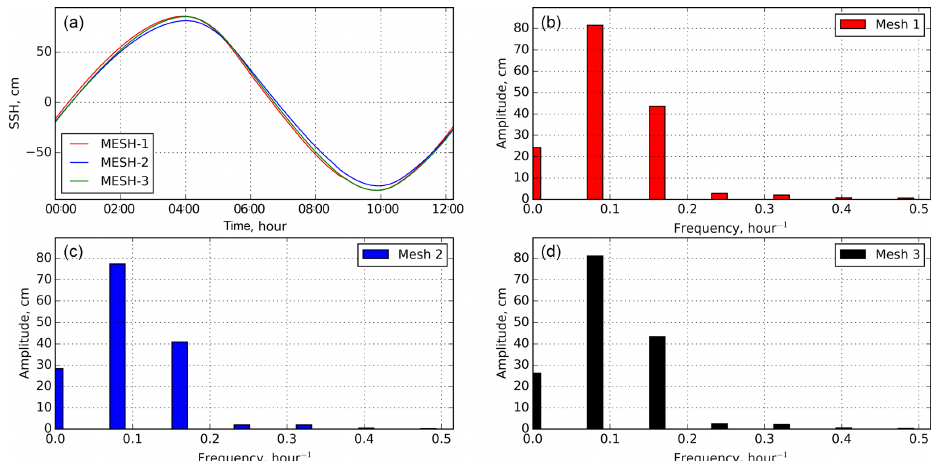
Figure 5. (a) Sea surface height (SSH) for one tidal period in the station List-auf-Sylt (see Fig. 2); (b) spectrum of the computed M 2 tidal sea level at station List-auf-Sylt on MESH-1; (c) spectrum on MESH-2; and (d) spectrum on